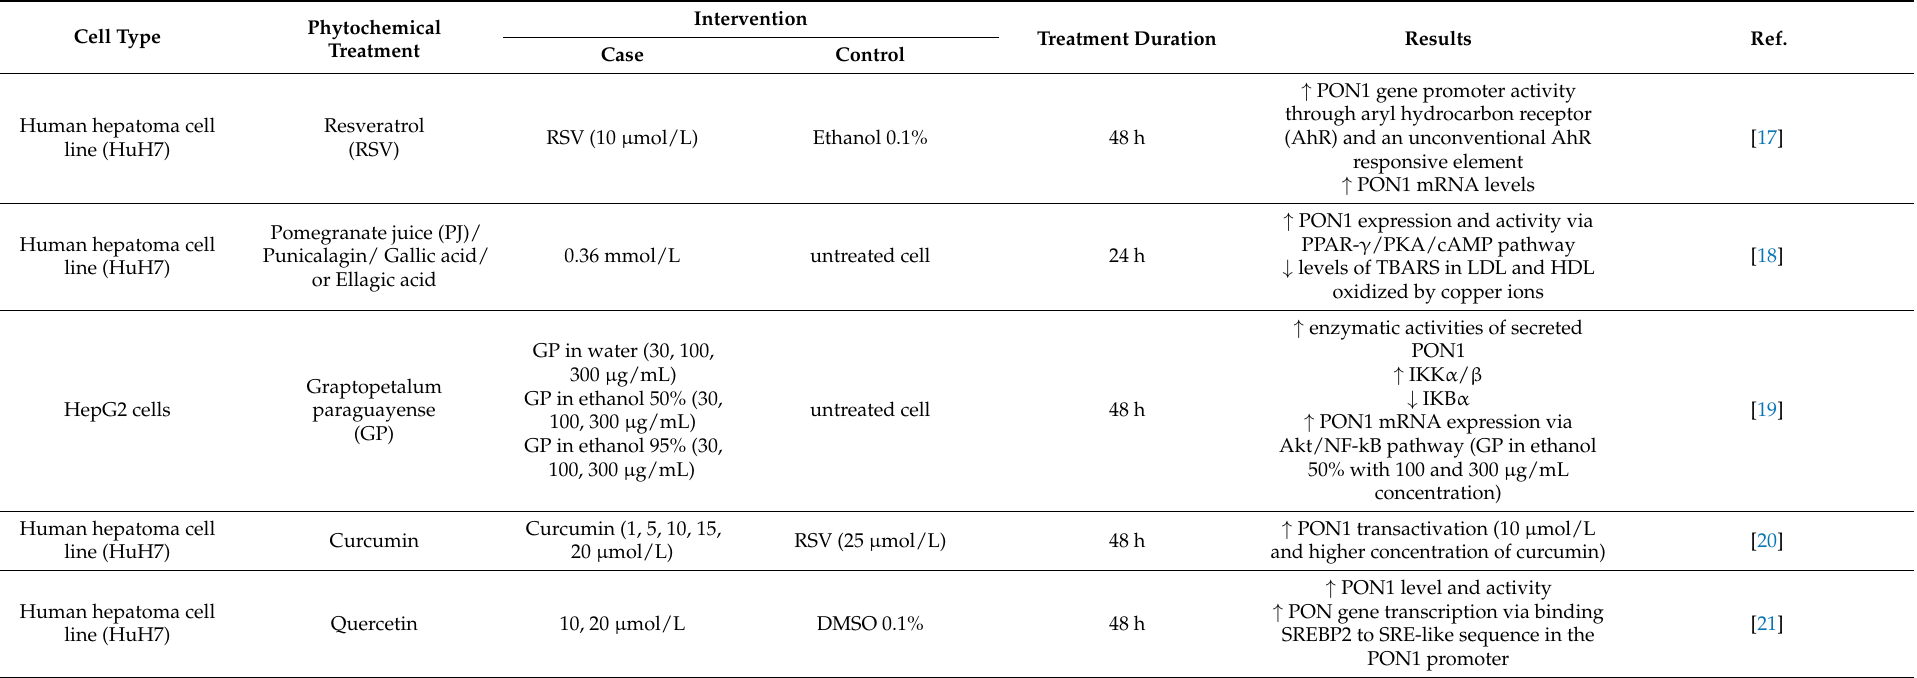
Table 1. Effects of phytochemicals on PON1 signalling pathways: in vitro